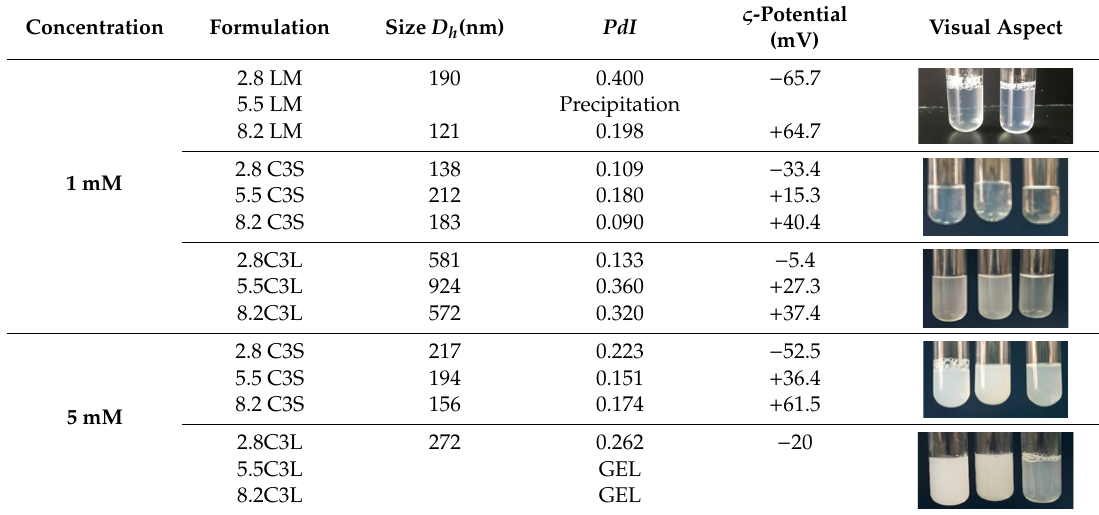
Table 4. Mean diameter, polydispersity index ( PdI ), ς -potential values, and visual appearance of the catanionic mixtures with cholesterol (1 mM) at day 0. Photographs corresponding to the C3L and C3S systems: left 8.2, center 5.5, and right 2.8. ς -Potential Cholesterol Formulation Size Dh (nm) PdI Visual (mV)